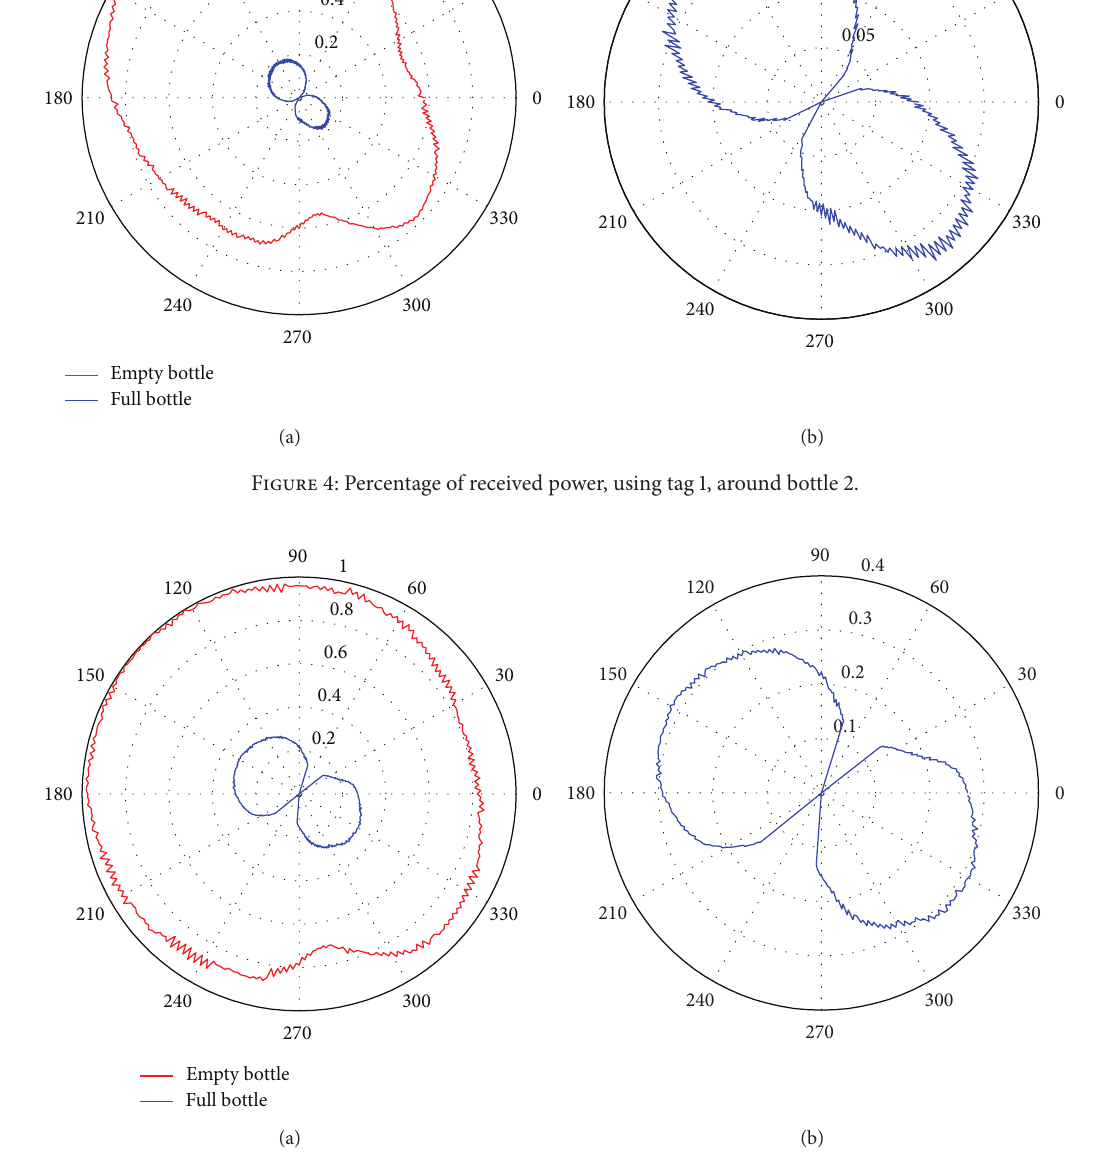
Figure 5: Percentage of received power, using tag 2, around bottle